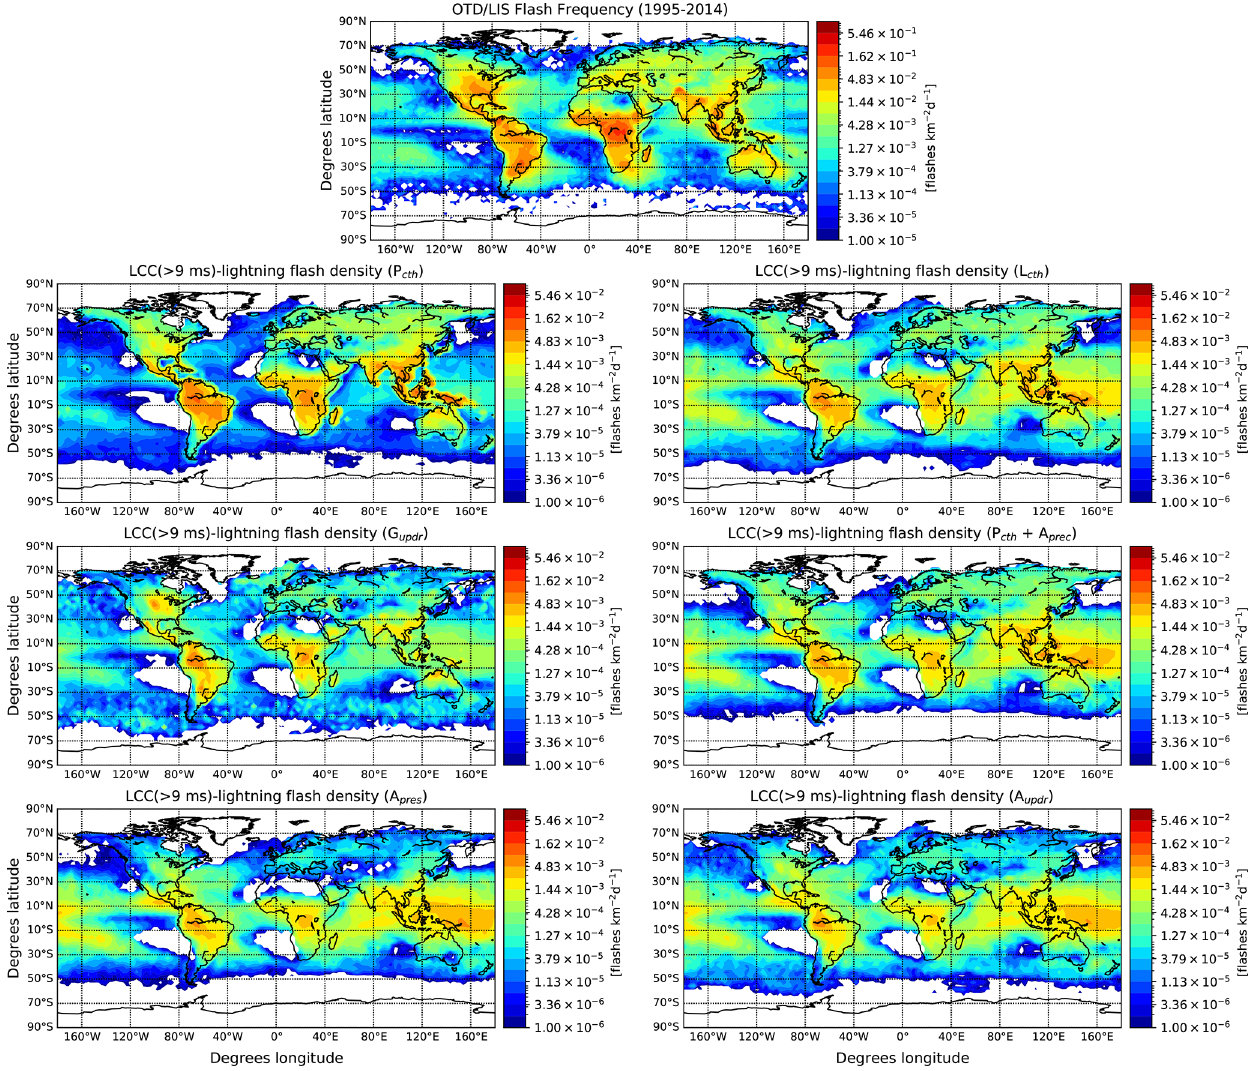
Figure 5. Global annual lightning observations (upper panel) by OTD/LIS as in Fig. 4. Simulated annual average LCC( > 9ms) lightning flash density (remaining panels) between 1 March 2017 and 28 February 2018 using different lightning parameterizations.